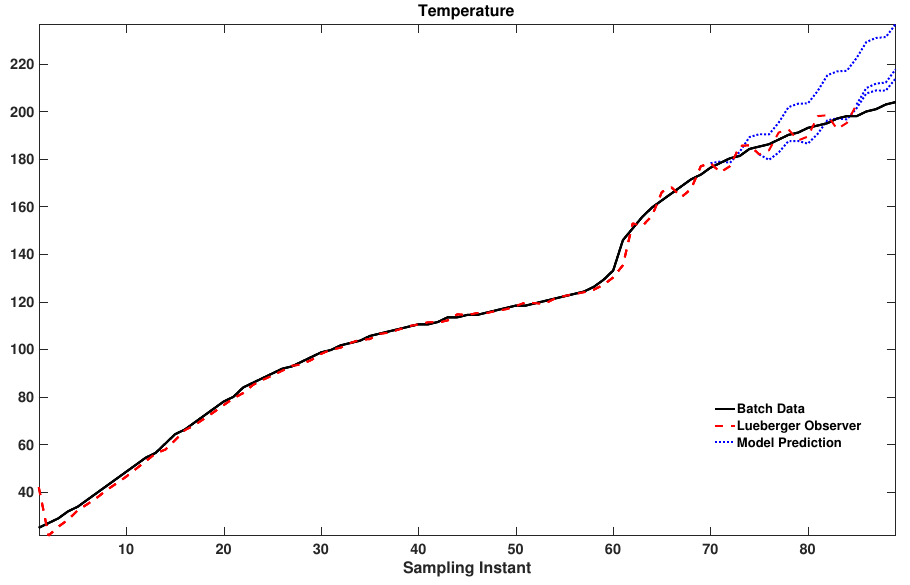
Figure 3. Model validation on a ‘new’ batch (heating phase